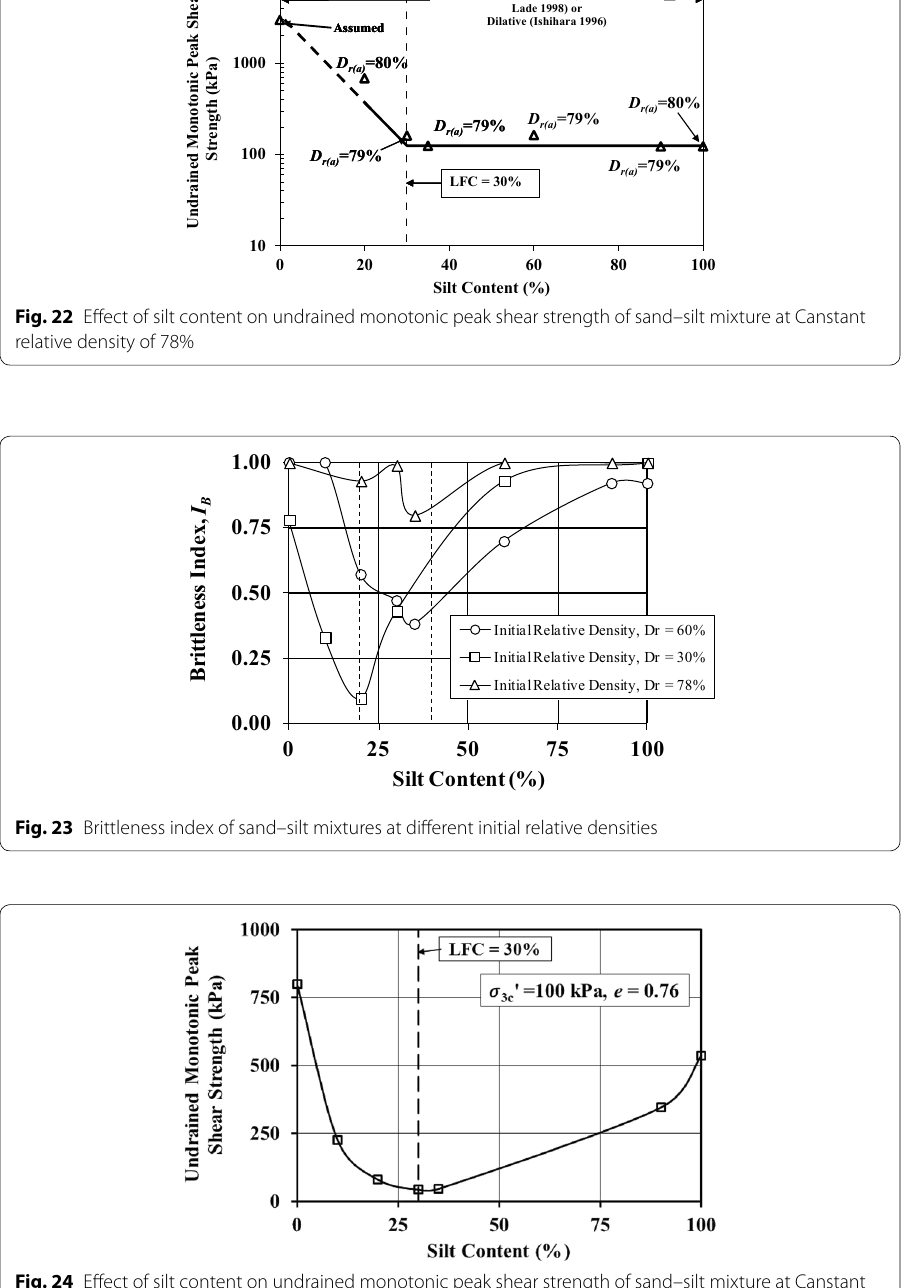
Fig. 24 Effect of silt content on undrained monotonic peak shear strength of sand–silt mixture at Canstant gross void ratio